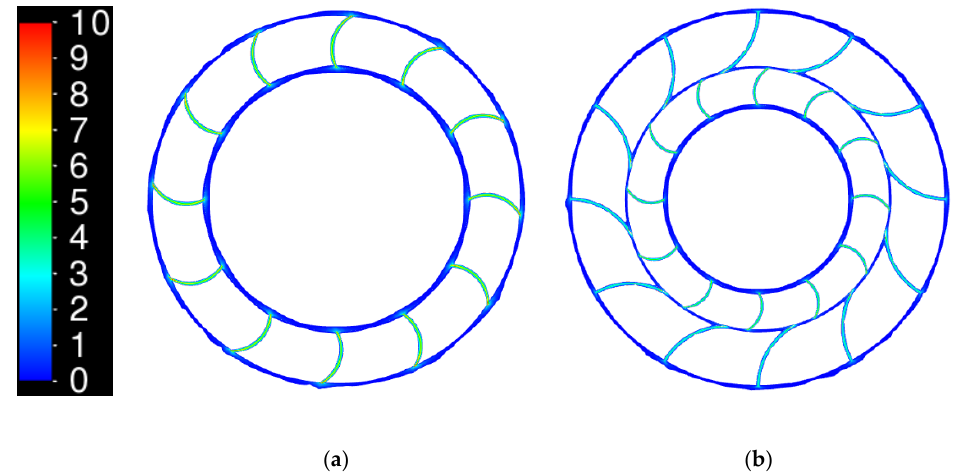
Figure 4. Variations of ϕ in the near-wall regions of the VAWT ( a ) without stator; ( b ) with stator. Table 1. Boundary conditions specified to the numerical